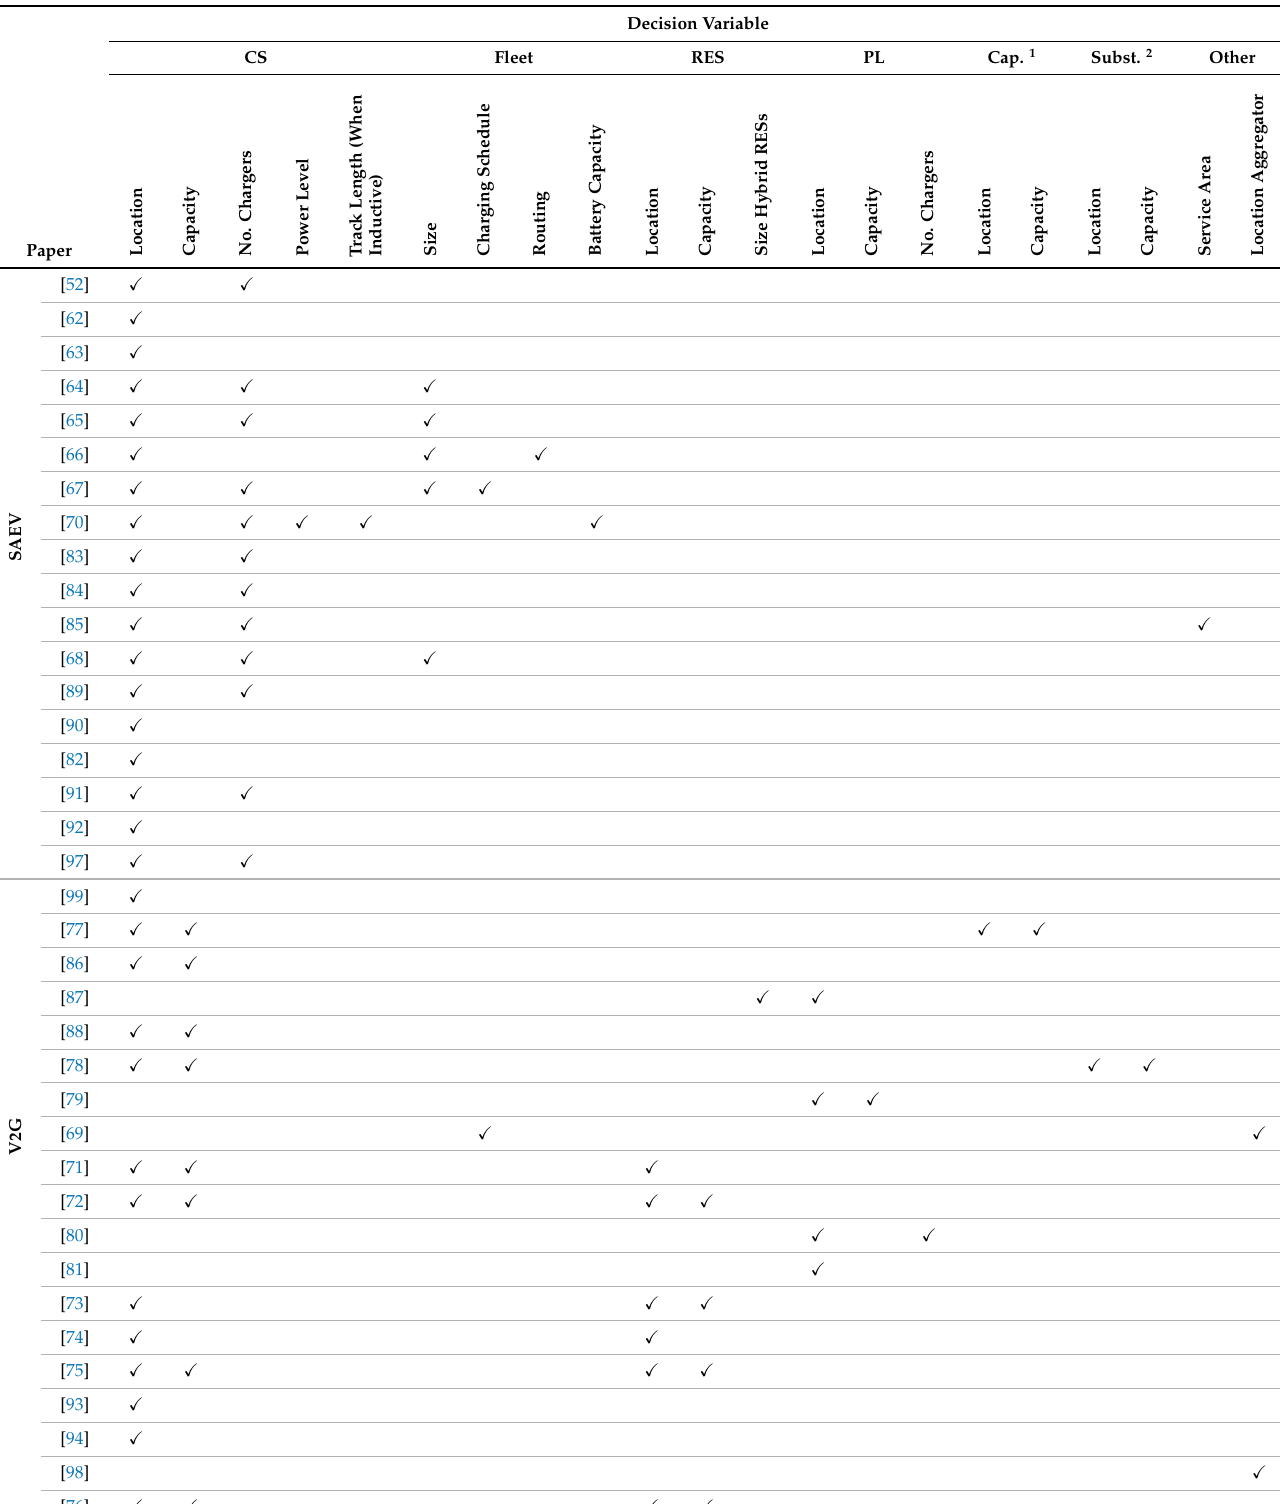
Table A1. The different decision variables considered by SAEV and V2G papers. Decision Variable CS Fleet RES PL Cap. 1 Subst. 2